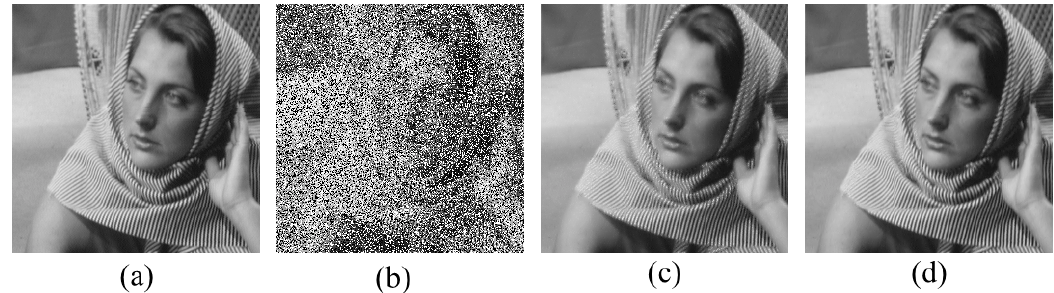
Figure 3. Comparisons on the denoised Barbara images using different norms. ( a ) is the noise-free image, ( b ) is the noisy image, ( c ) and ( d ) are denoised images using FDLCP with L 1 and L 0 norm minimizations, respectively. Note: The noise level is 0.5, meaning that 50% pixels are contaminated by salt and pepper noise.